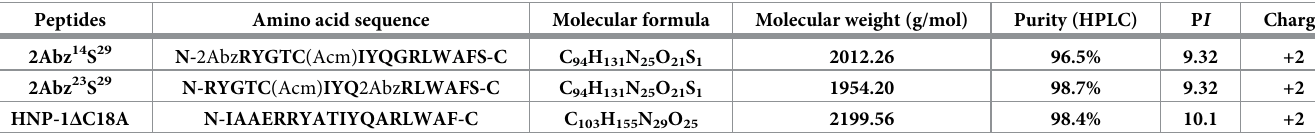
Table 1. Properties of synthetic peptides. Peptides Amino acid sequence Molecular